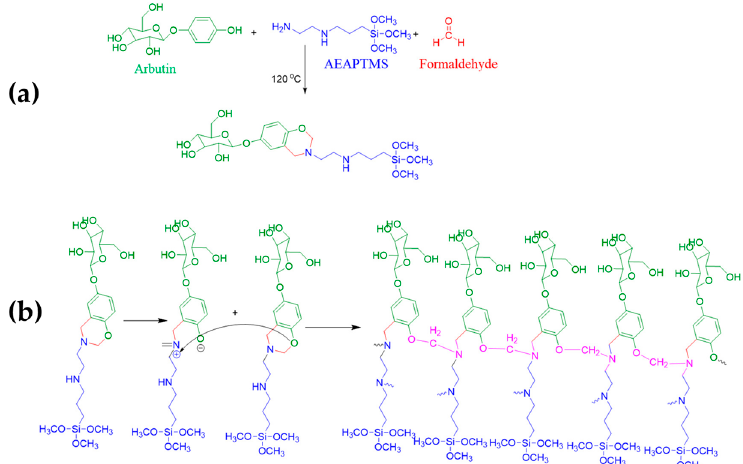
Figure 21. Arbutin-based benzoxazine monomer synthesis reaction ( a ) and synthetic pathway for the arbutin-based benzoxazine polymerization ( b ). Reprinted with permission from Ref. [74]. Copyright 2022, T. Periyasamy, Progress in Organic Coatings, Elsevier.